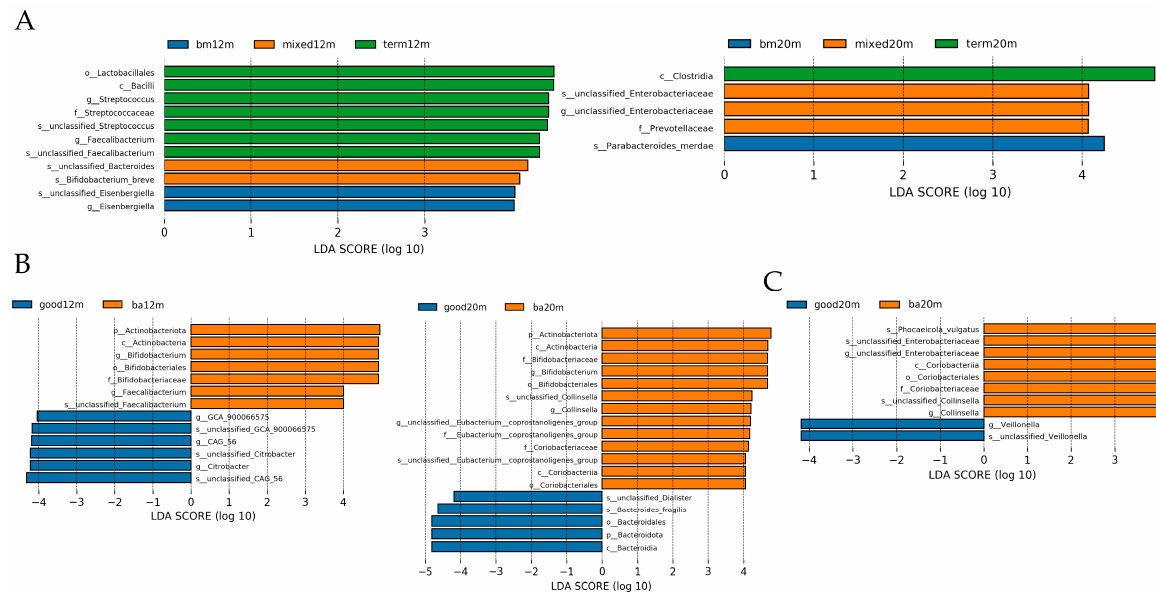
Figure 5. LDA by Lefse illustrating differential bacterial taxa of the gut microbiota community in each group varied by feeding mode or neurodevelopment outcomes at different sampling times. ( A ) differential bacterial taxa varied by feeding mode at 12 and 20 months; ( B ) differential bacterial taxa varied by language composite score at 12 and 20 months; ( C ) differential bacterial taxa varied by cognitive composite score at 12 and 20 months. Figure legend: bm, breast milk; ba, below average; m, months.